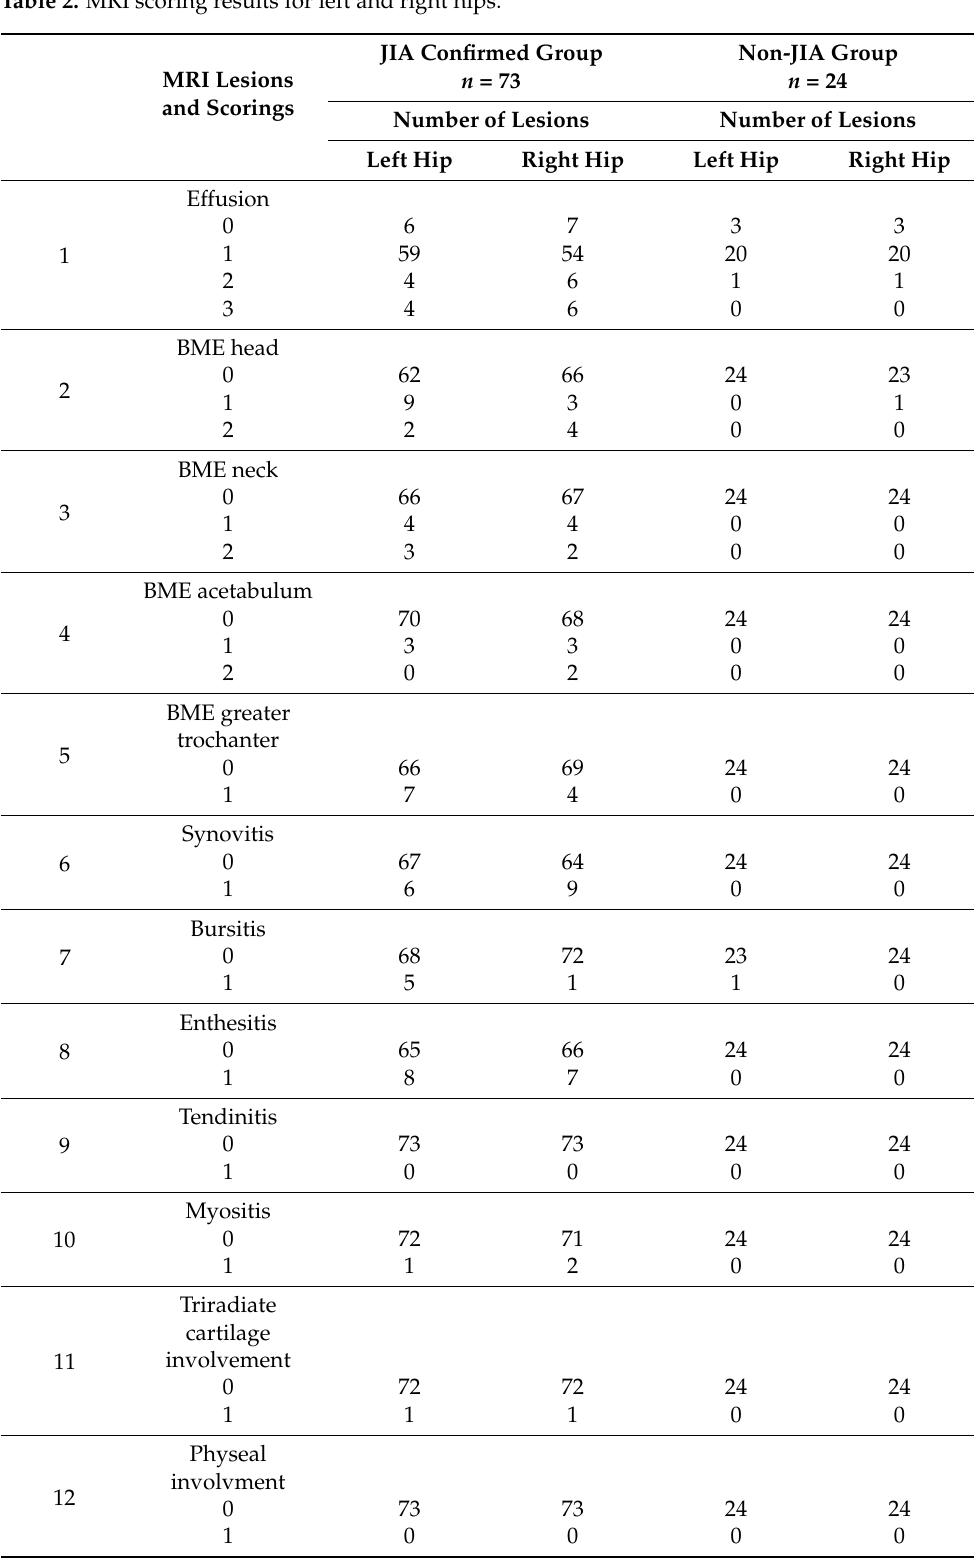
Table 2. MRI scoring results for left and right